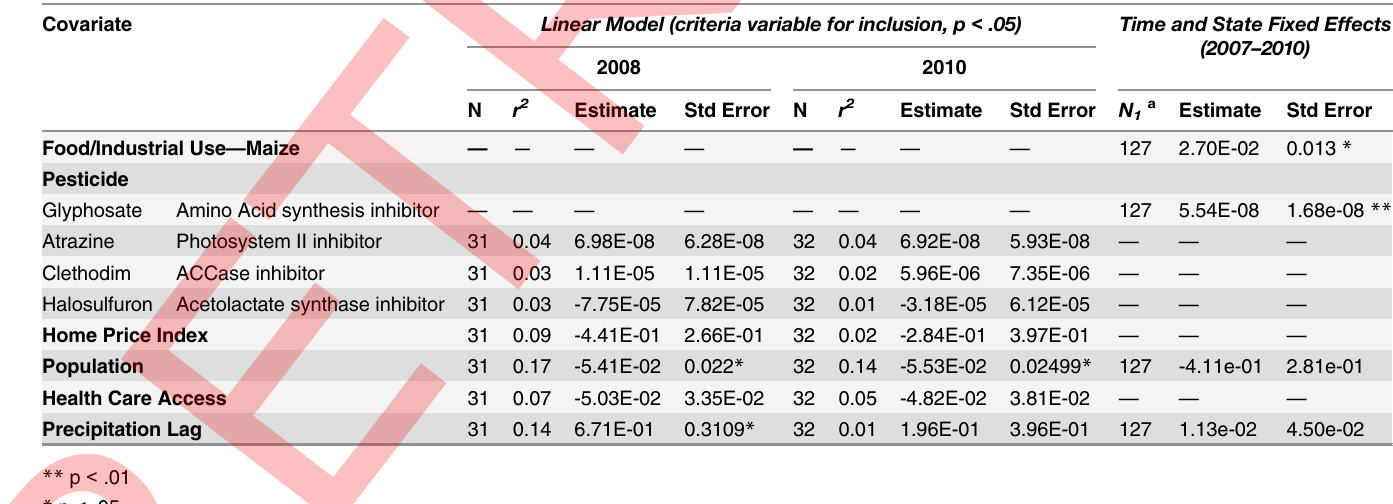
Table 3. The effect of herbicide use and other covariates on ADHD hospital discharges, showing the initial OLS screening for each predictor for 2008 and 2010 and all significant predictors in a two ways effects within model in R, adjusting for heteroskedasticity and serial correlation. Covariate Linear Model (criteria variable for inclusion, p <